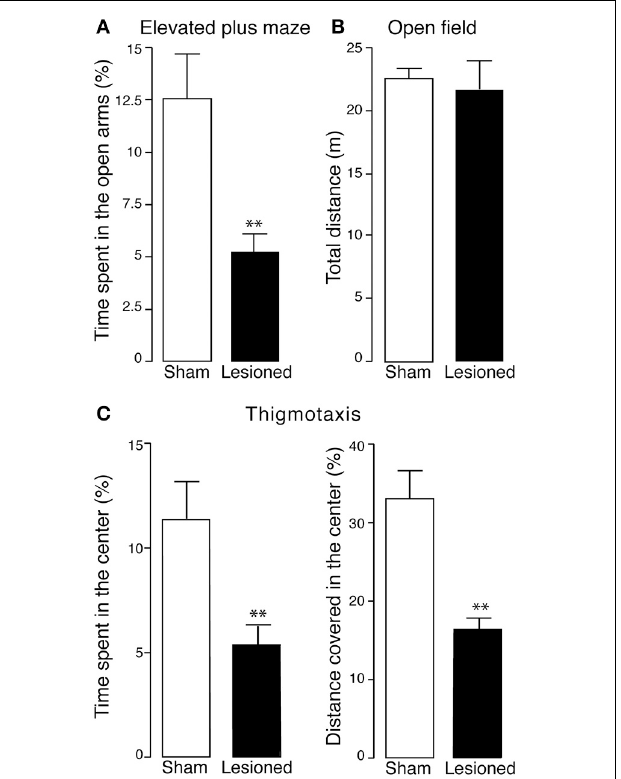
FIGURE 4 | Anxiety-like phenotype in 6-OHDA-lesioned mice. Sham and 6-OHDA-lesioned (Lesioned) mice were tested for anxiety-like behavior in the elevated plus maze (A) and open field (B,C) . (A) In the elevated plus maze, the time spent in the open arms (% of the test duration) by sham ( n = 12) and 6-OHDA-lesioned mice ( n = 15) mice, was measured during a 5min test. (B) In the open field, the total distance (m) covered by sham ( n = 11) and 6-OHDA-lesioned mice ( n = 8) mice was measured, during a 15min test. (C) Thigmotaxis was evaluated in the open field by measuring the time spent (% of total test duration) and the distance covered (% of total distance covered) in the center of the apparatus (left and right panel, respectively). Data are expressed as mean ± s.e.m. ∗∗ p < 0 . 01 vs. sham mice, Student’s t